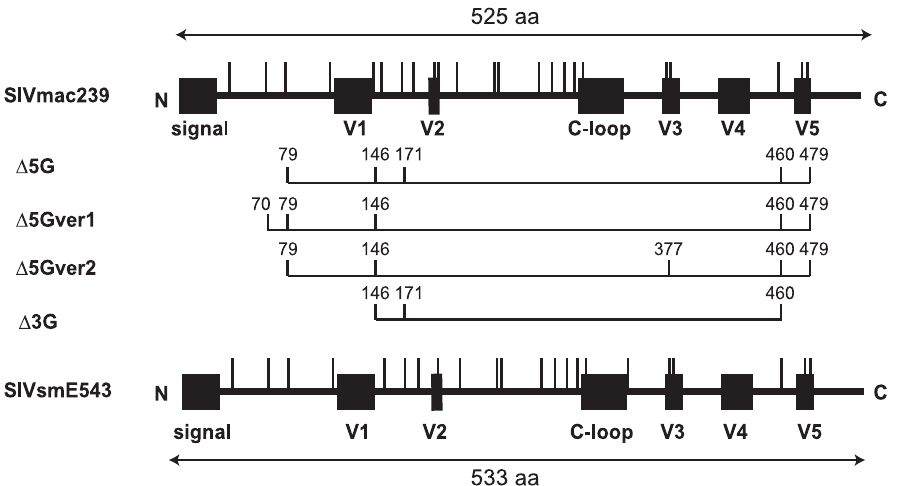
Figure 1. Live attenuated vaccines with deglycosylation mutations. N-glycosylation sites (vertical bars) localized within gp120 of SIVmac239 and SIVsmE543-3 are shown. SIVmac239 and SIVsmE543-3 have 23 and 22 N -glycosylation sites, respectively. The position of N-glycosylation sites mutated to remove the specific glycans for D 5G, D 5Gver-1, D 5Gver-2, and D 3G were indicated and constructed by site-directed mutagenesis based on SIVmac239. V1 to V5 indicate variable region 1 to 5 respectively. C-loop indicates the constant loop region within SIVmac239 [15].